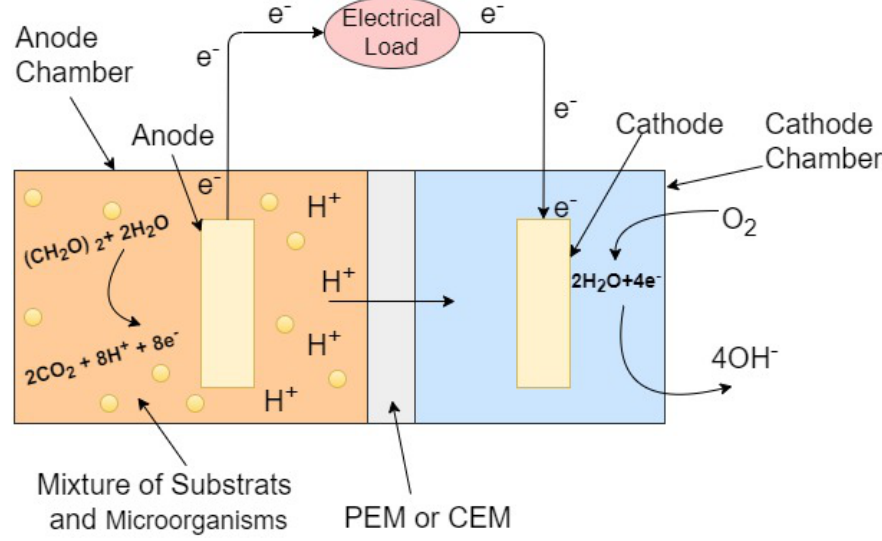
Figure 4. Dual Chamber MFC with Pure Culture Microorganism